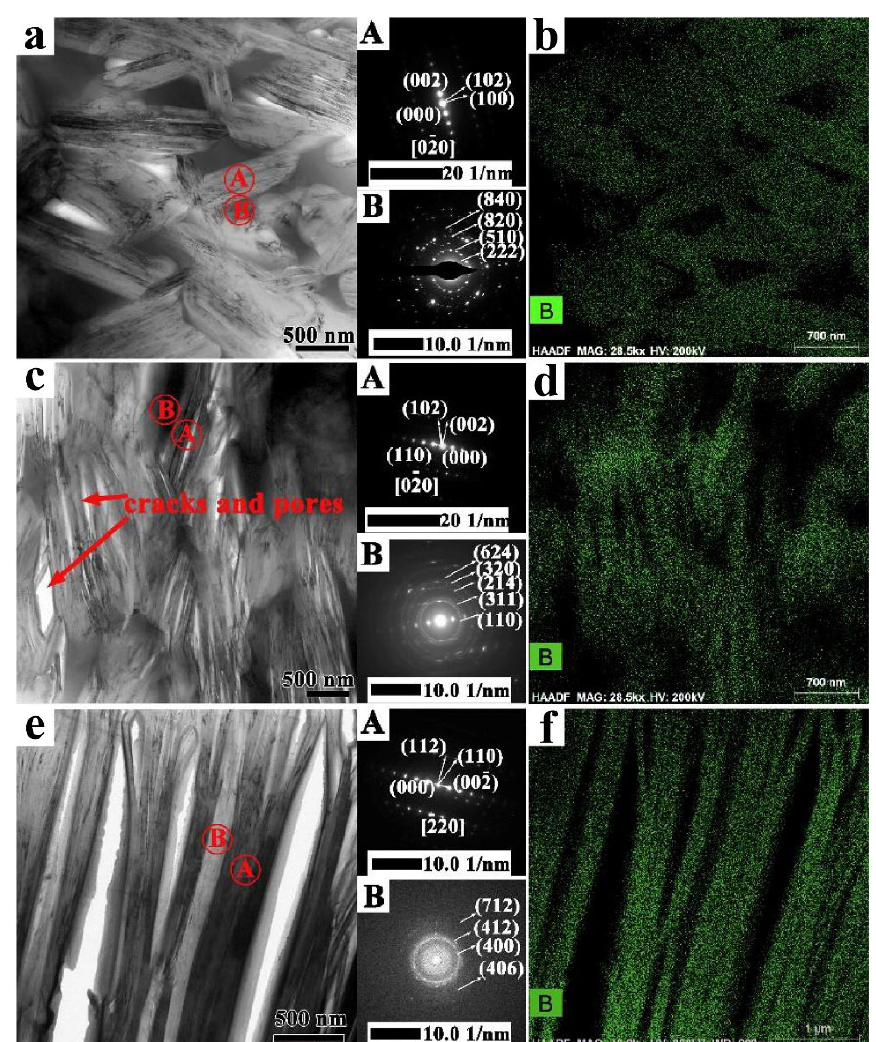
Fig. 4 Bright field TEM images, corresponding SAED patterns, and elemental distributions of boron for textured h-BN-MAS composites prepared from h-BN powders with different sizes: (a, b) 0.5 μm; (c, d) 5.0 μm; (e, f) 11.0 μm. Reproduced with permission from Ref. [70], © Elsevier Ltd.